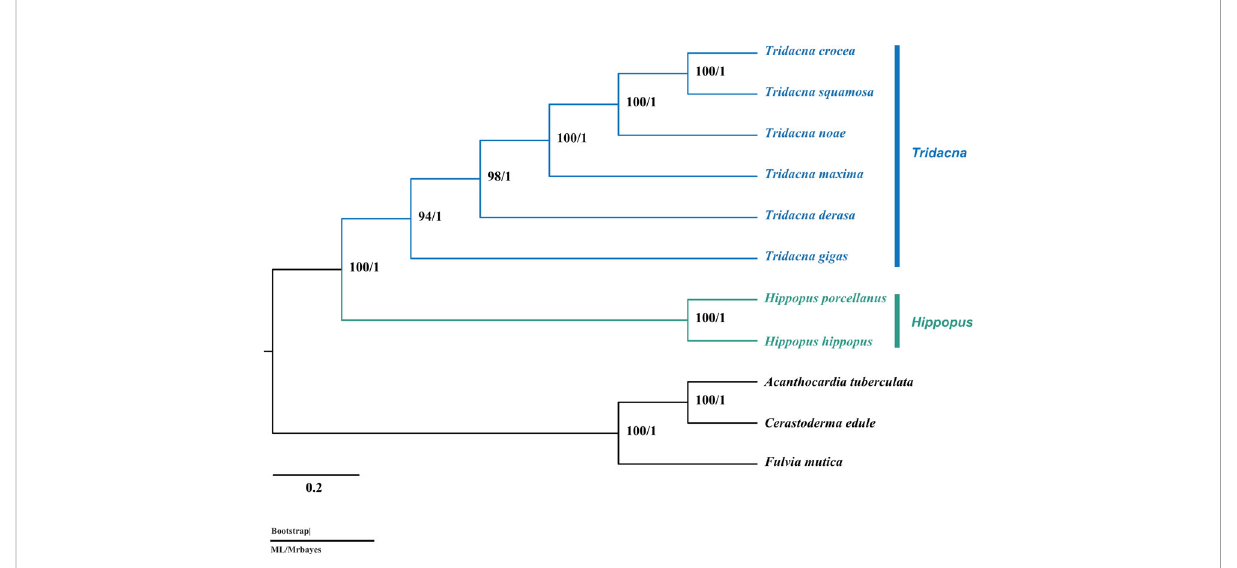
FIGURE 4 Consensus phylogenetic tree of giant clam species and outgroups from Maximum likelihood and Bayesian inference methods based on a concatenated nucleotide data set containing 13protein-coding genes and 18S rRNA